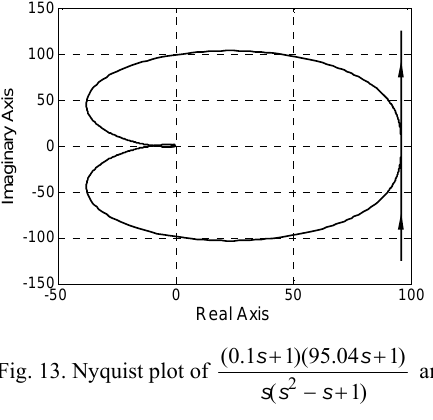
Fig. 13. Nyquist plot